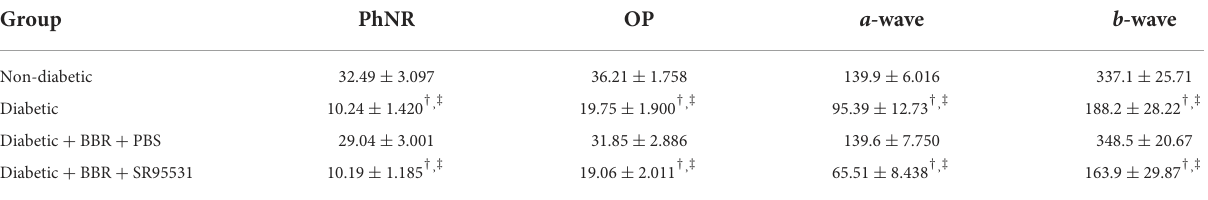
TABLE 2 Mean amplitude of ERG components in all experimental